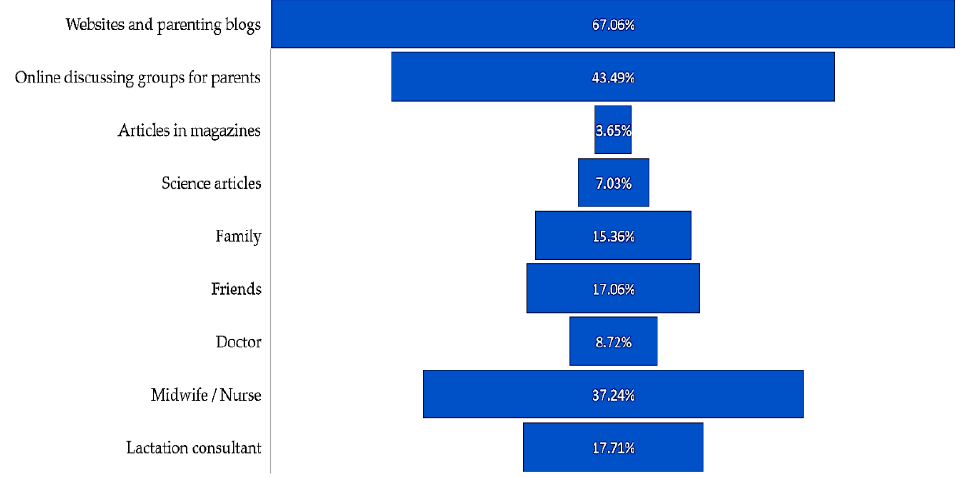
Figure 6. Source of mothers’ knowledge about the possibilities of non-nutritional use of breast milk (multiple choice question).